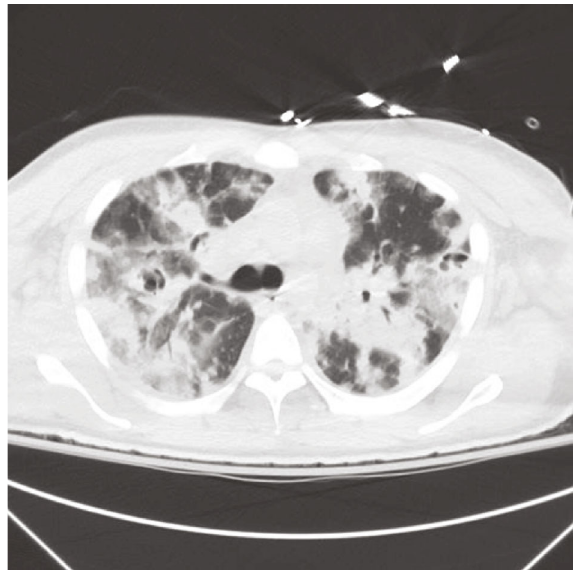
Figure 1: Initial CT chest without contrast fi ndings.